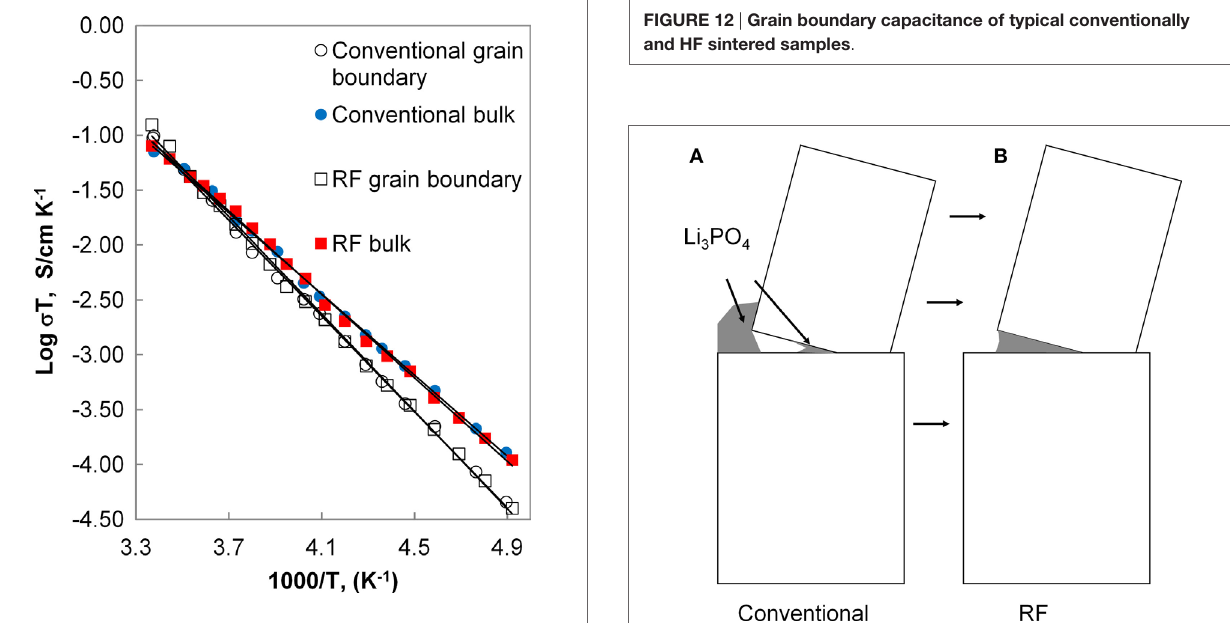
FigUre 11 | arrhenius plot of bulk and grain boundary conductivity for conventional and hF sintered samples .